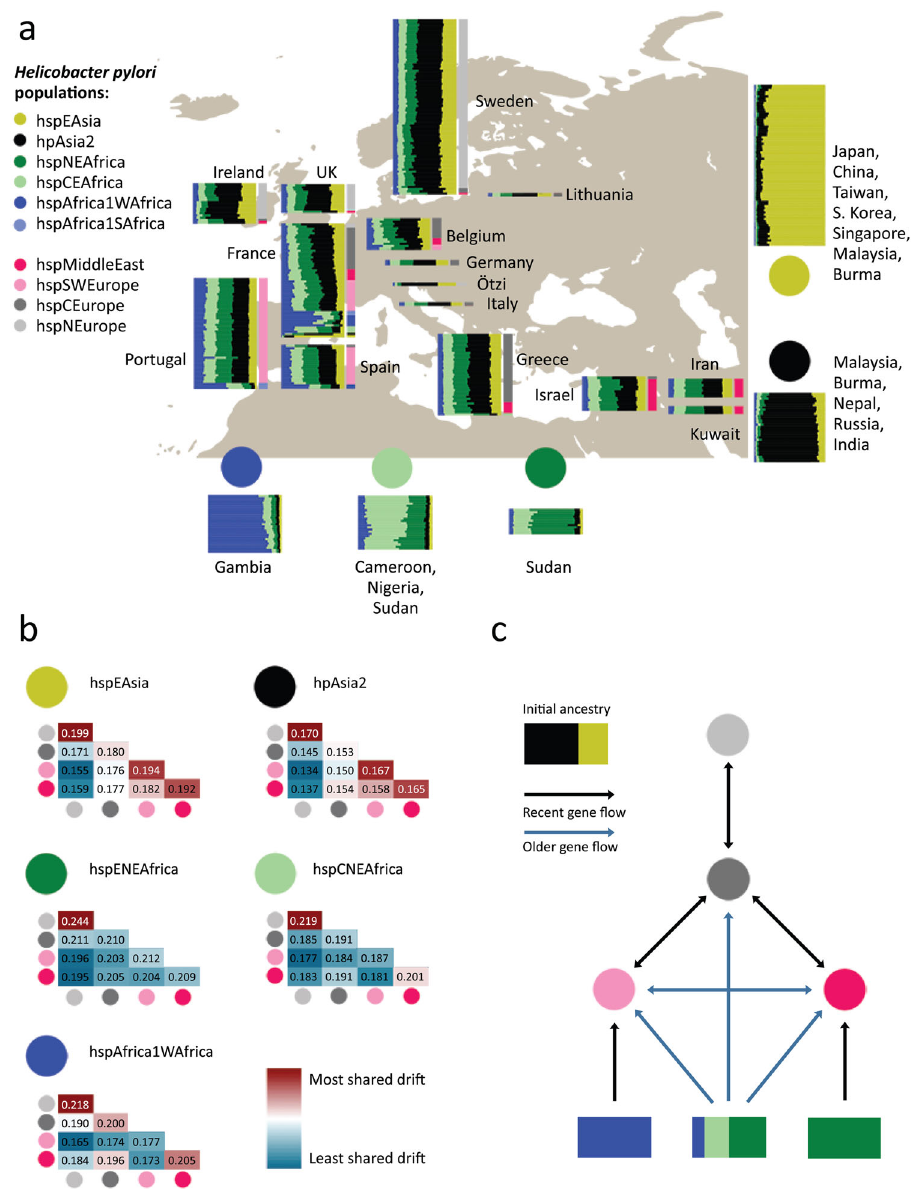
Fig. 1 | Ancestry and migration history ofhpEurope isolates. a Painting pro fi les ofhpEuropeisolatesandtheirputativeancestralpopulationsfromAfricaandAsia showing proportion of each genome (horizontal bar) painted by each of fi ve ancestral donor populations (circles). hpEurope isolates are grouped by country ofisolation,withbarstotherightindicatingthe H.pylori populationeachstrainis assignedto. Therepresentativeisolatesfrom eachdonor population aregrouped